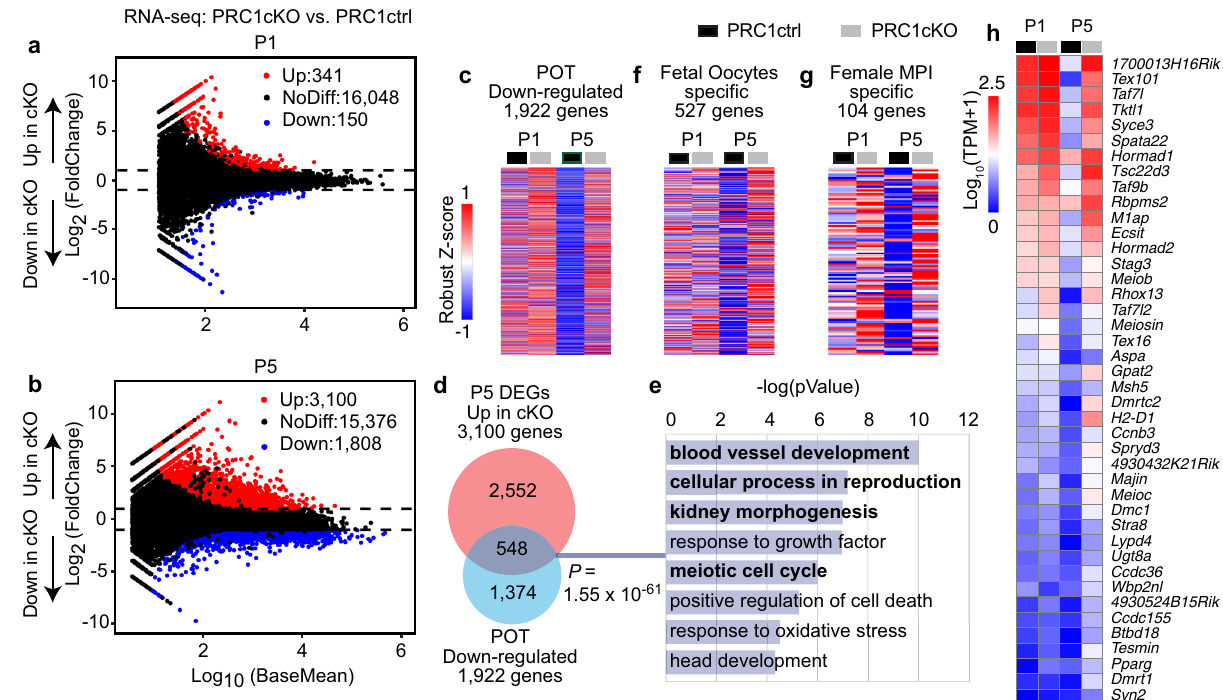
Fig. 3 PRC1 de fi ciency causes extensive transcriptional misregulation and defective POT. a , b Comparison of transcriptomes between PRC1ctrl and PRC1cKO oocytes at P1 and P5, respectively. ~300 – 500 nongrowing oocytes isolated from P1 or P5 ovaries were pooled as one replicate, and two independent biological replicates were examined for RNA-seq. All the genes with False Discovery Rate (FDR) values are plotted. Differentially expressed genes (DEGs: Log 2 FoldChange > 1, FDR < 0.05) are colored (red: upregulated in PRC1cKO oocytes; blue: downregulated in PRC1cKO oocytes), and numbers are shown. FDR values are the P adj values generated by DESeq2 by default, in which P values attained by the Wald test were corrected for multiple testing using the Benjamini and Hochberg method. c , f , g , h Heatmaps showing expression of POT-down-regulated genes (1922 genes: c ), fetal oocytes genes (527 genes: f ), female MPI-speci fi c genes (104 genes: g ), and 42 overlapped genes between 104 MPI genes and the P5 up-regulated DEGs ( h ) in PRC1ctrl and PRC1cKO oocytes. d Overlap between up-regulated DEGs at P5 and POT down-regulated genes. When considering the ratio of POT down-regulated genes to all genes in the genome (1922 genes divided by all 21,169 genes detected in the genome), this association (548 genes divided by 3100 genes) is statistically signi fi cant ( P = 1.55 × 10 − 61 , two-sided hypergeometric test). e Key GO enrichments in the overlap detected in d . Source data are provided as a Source Data fi mutant oocytes had a global gain of H3K4me3 around TSSs (Fig. 4c, d), particularly on gene Clusters 2-4 (Fig. 4c, Supplementary Fig. 6c), while the overall genomic distribution mentary Fig. 6a). By contrast, in PRC1cKO P1 oocytes, H3K4me3 remained unchanged (Fig. 4c). On the other hand, overall H3K27me3 was modestly reduced, except for gene Cluster 1, which showed a modest increase in mutant oocytes (Fig. 4d, Supplementary Fig. 6c). ChIP-x Enrichment analysis (ChEA) analysis, which detects overlaps with putative binding loci identi fi ed in the public next-gen sequencing database, revealed that Cluster 1 genes are common targets of various Polycomb embryonic stem cells (ESCs: Supplementary Fig. 7a) and are associated with transcription and developmental processes (Supplementary Fig. 7b). However, as indicated by the increase of H3K4me3 in mutant oocytes, PRC1 regulates a much larger set of genes (9144 genes including Cluster 2-4) that function in a broad range of biological processes including the ubiquitin- proteasome pathway and RNA processing (Cluster 2), DNA metabolic process (Cluster 3), and DNA repair (Cluster 4) (Supplementary Fig. 7b). Consistent with the overall global change, we also observed a signi fi cant gain of H3K4me3 and modest reduction of H3K27me3 around TSSs of the 104 MPI genes in PRC1cKO oocytes (Supplementary Fig. 6d), in line with Polycomb targets, PRC1 modulates chromatin at a wide range of genes during perinatal oogenesis.